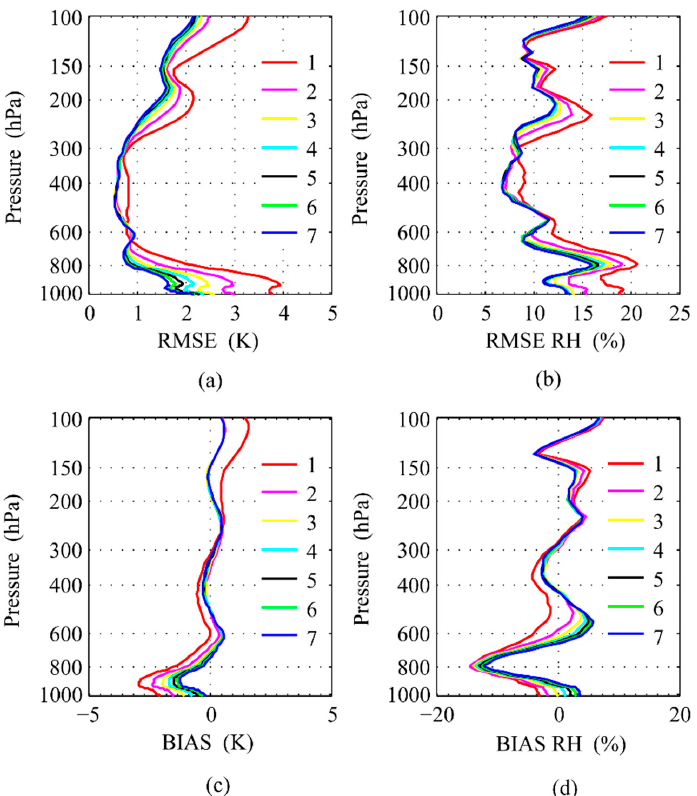
Figure 5. The retrieval results of FY-4A: ( a ) Temperature RMSE; ( b ) Humidity RMSE; ( c ) Tempera-